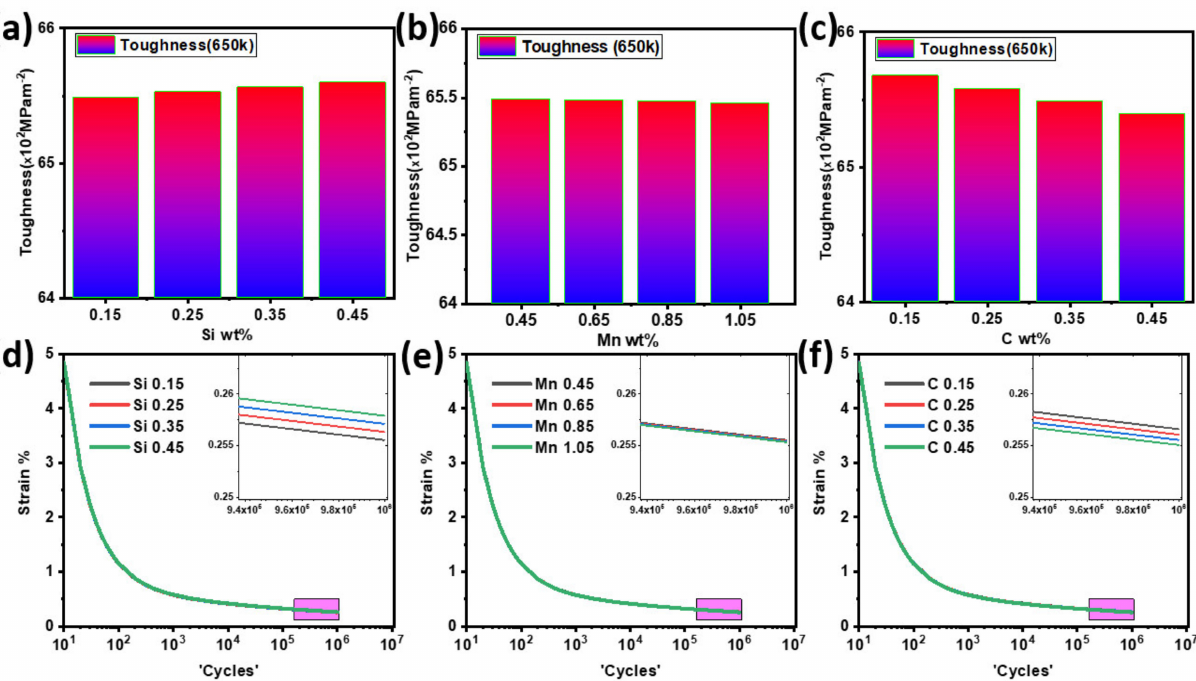
Figure 6. Jmat-Pro simulations for ( a ) Toughness at 650 K w.r.t Si wt.%; ( b ) Toughness at 650 K w.r.t Mn wt.%; ( c ) Toughness at 650 K w.r.t C wt.%; ( d ) Fatigue rate at 650 K w.r.t Si wt.%; ( e ) Fatigue rate at 650 K w.r.t Mn wt%; ( f ) Fatigue rate at 650 K w.r.t C